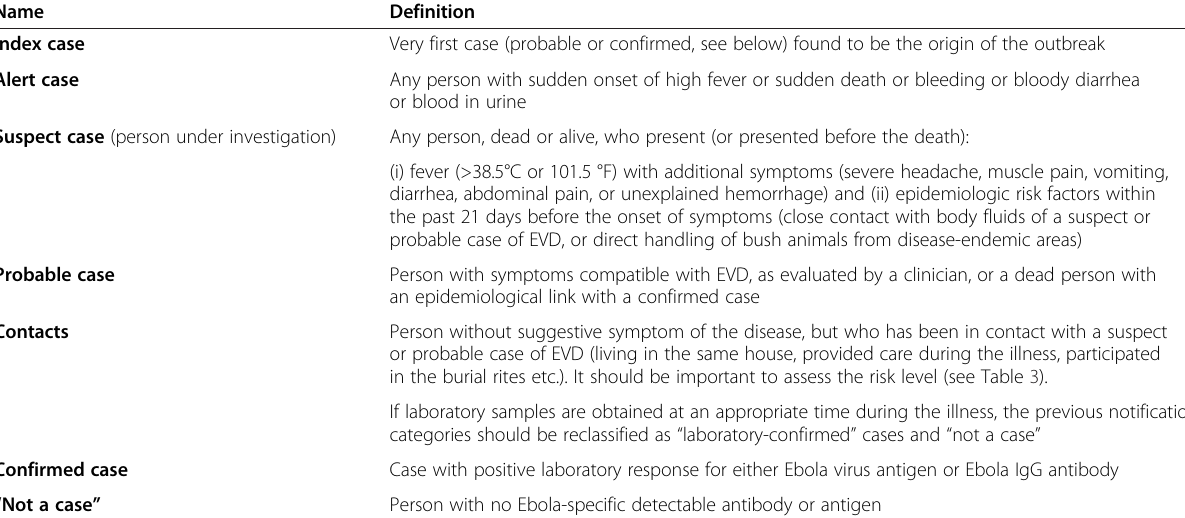
Table 2 Case definition of Ebola Virus Disease (EVD) [23,34]